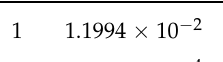
( x ) − 2 π x p (cid:107) y p 1